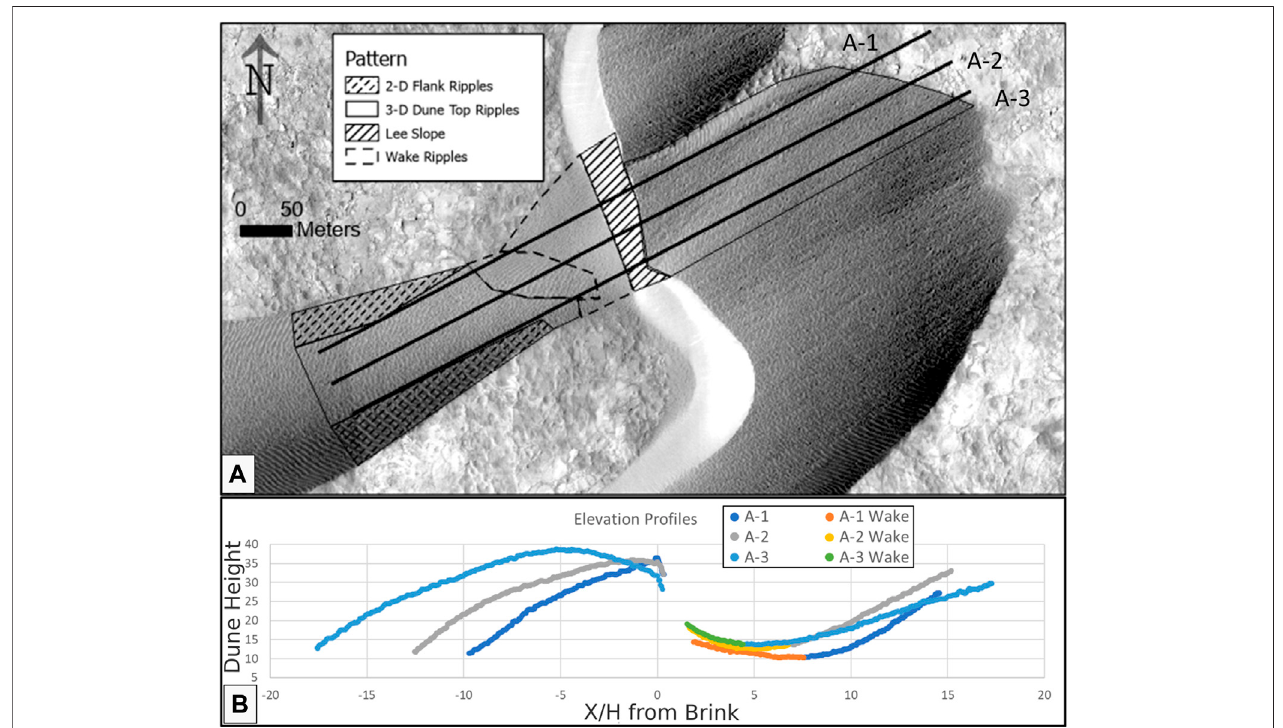
FIGURE4| ImageofDuneAwithripplesandtransectsmapped.Elevationalongeachtransectisshowninthelowerrightcorner,withleeslopesremovedforclarity and areas mapped as “ Wake Ripples ” highlighted in the pro fi le. The distance from the brink is measured positive in the downwind direction.